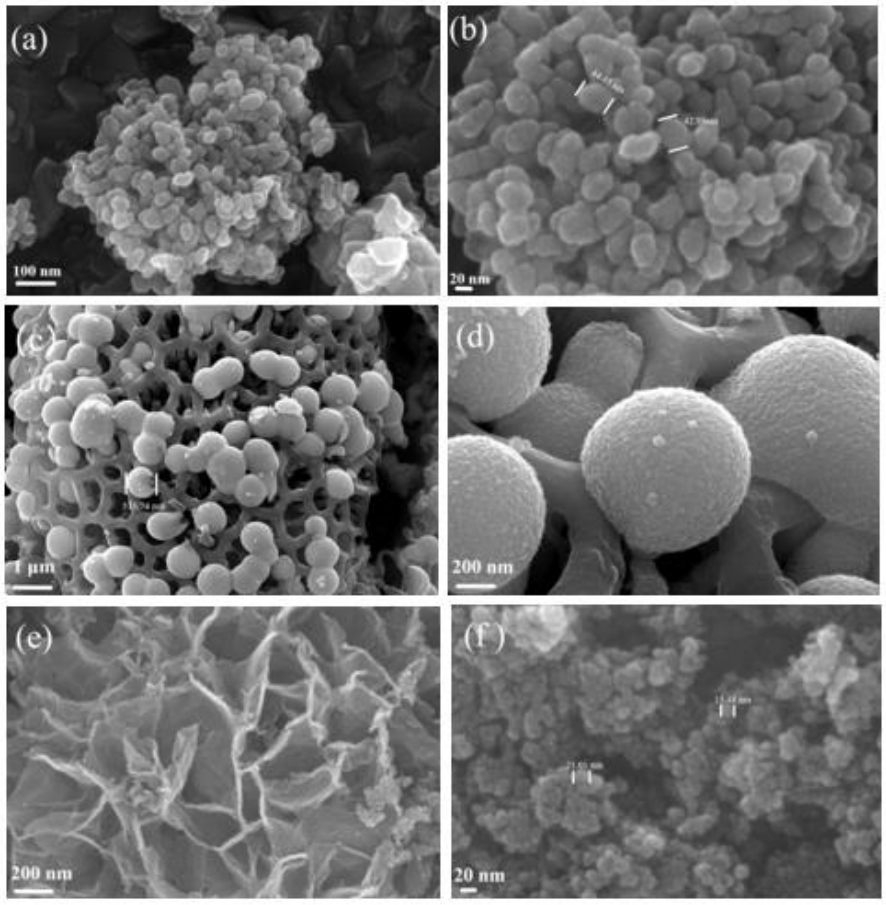
Figure 3. SEM images of Fe 2 O 3 @C-500 ( a , b ), CoO@C-500 ( c , d ), and NiO@C-500 ( e , f ). The specific surface was applied to characterize the performance, surface state, and